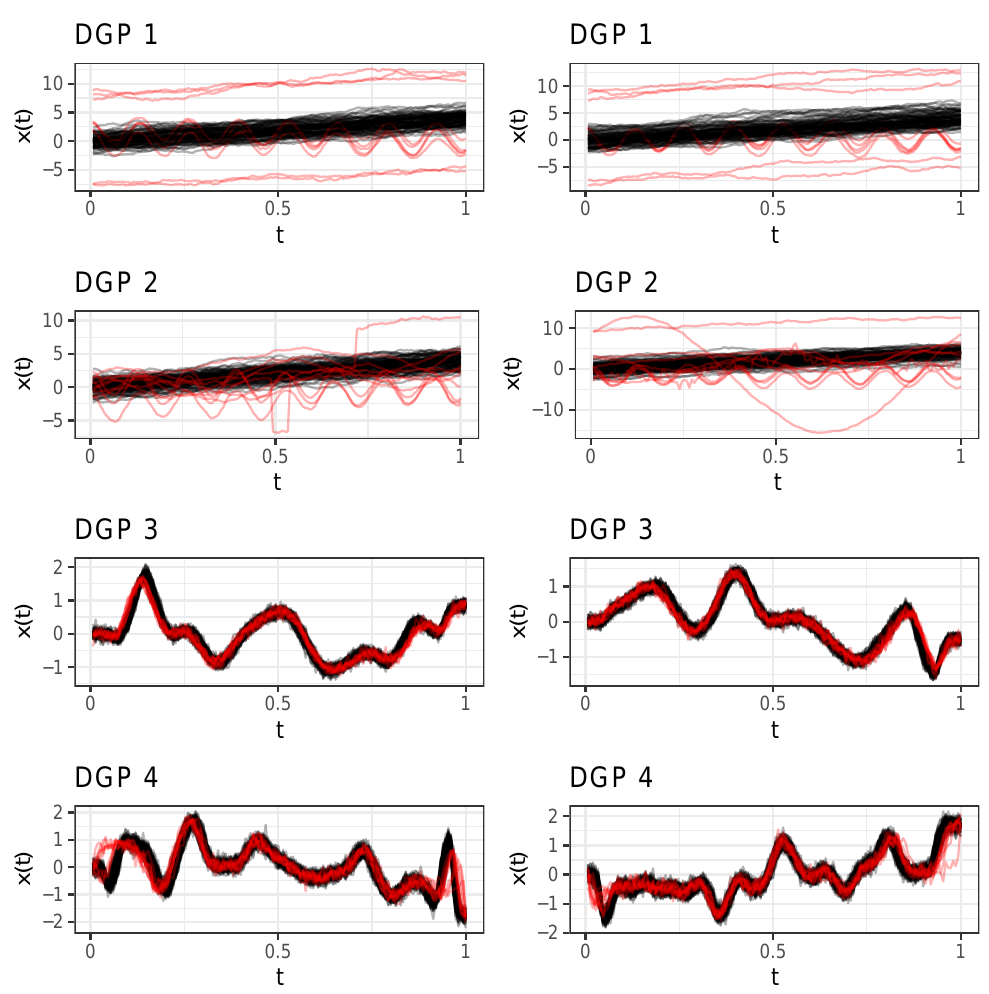
Figure A16. Example datasets for the DGPs used in the simulation study (2 each). Inliers in black; outliers in red. Outlier ratio 0.1; n =